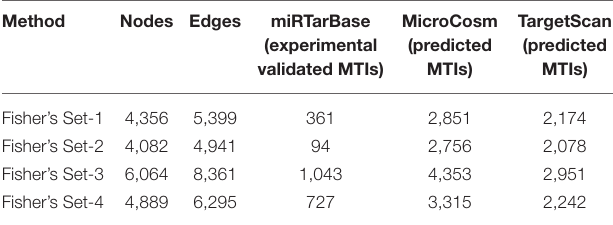
TABLE 3 | CyTargetLinker’s validated and predicted MTIs.